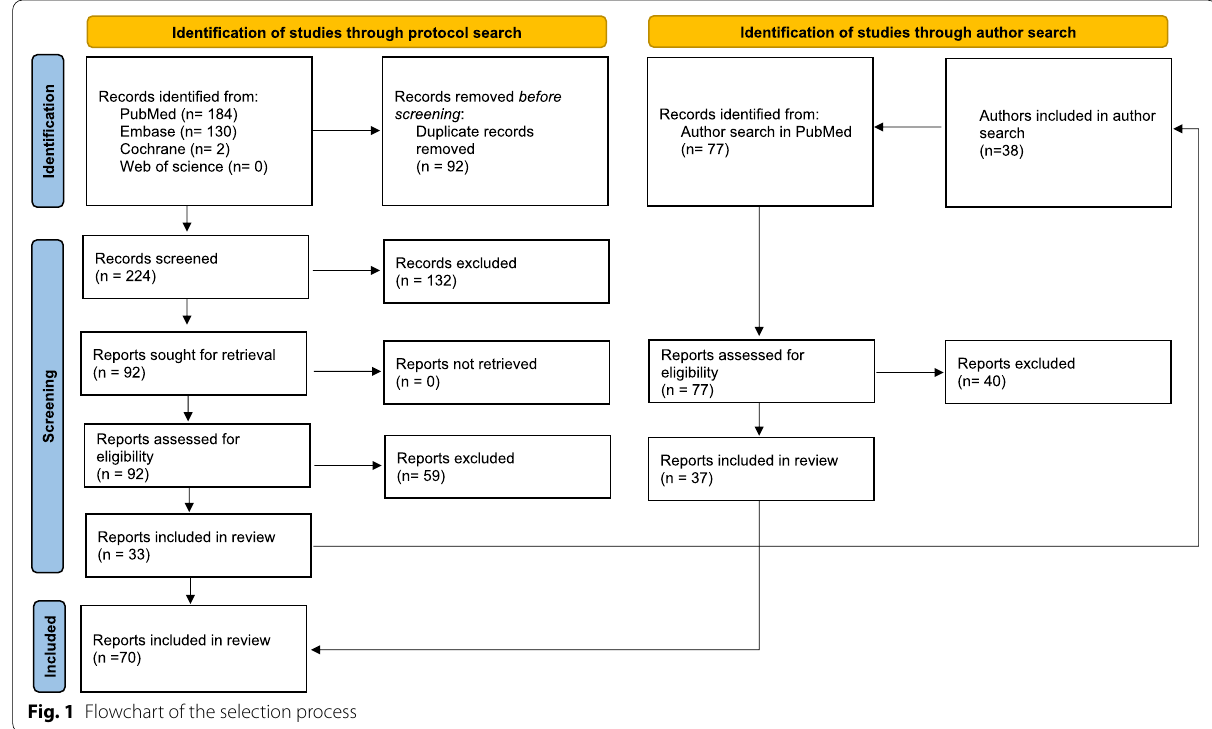
Fig. 1 Flowchart of the selection